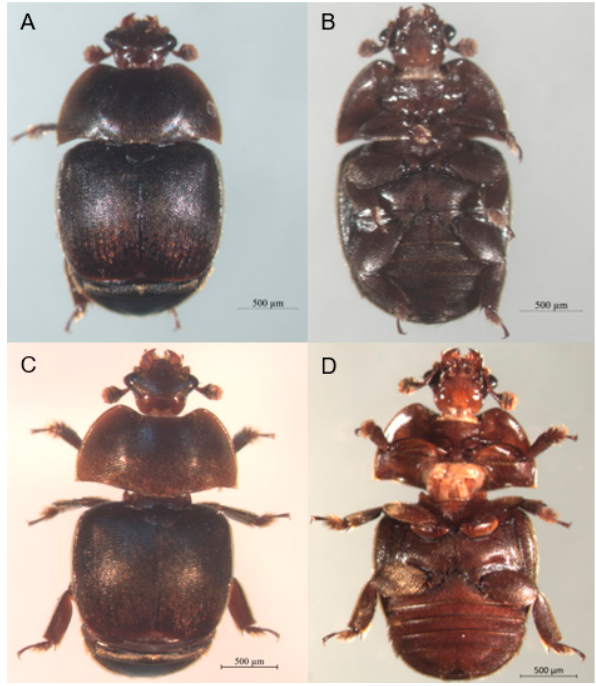
Figure 1. Photos of small hive beetles (SHBs). ( A , B ) Dorsal and ventral views of a female SHB; ( C , D ) Dorsal and ventral views of a male SHB. (photograph—Francisco Posada).